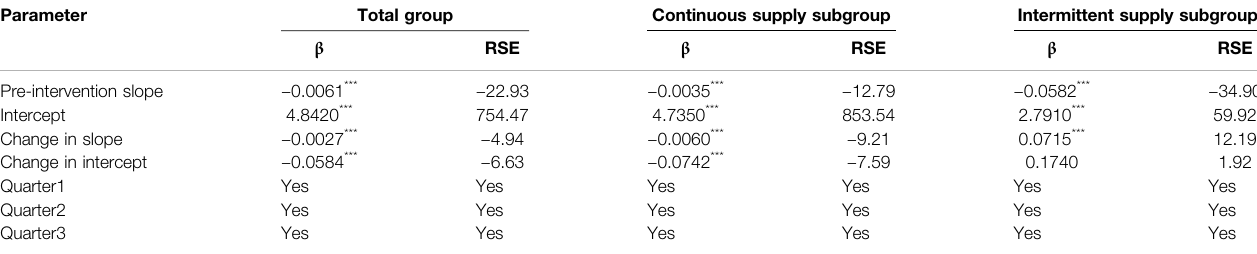
TABLE 4 | Estimated coef fi cients of segmented regression models for the LPCMs supply number before and after the LPMP from 2005 to 2018 ( N (cid:1) 56 quarters). Parameter